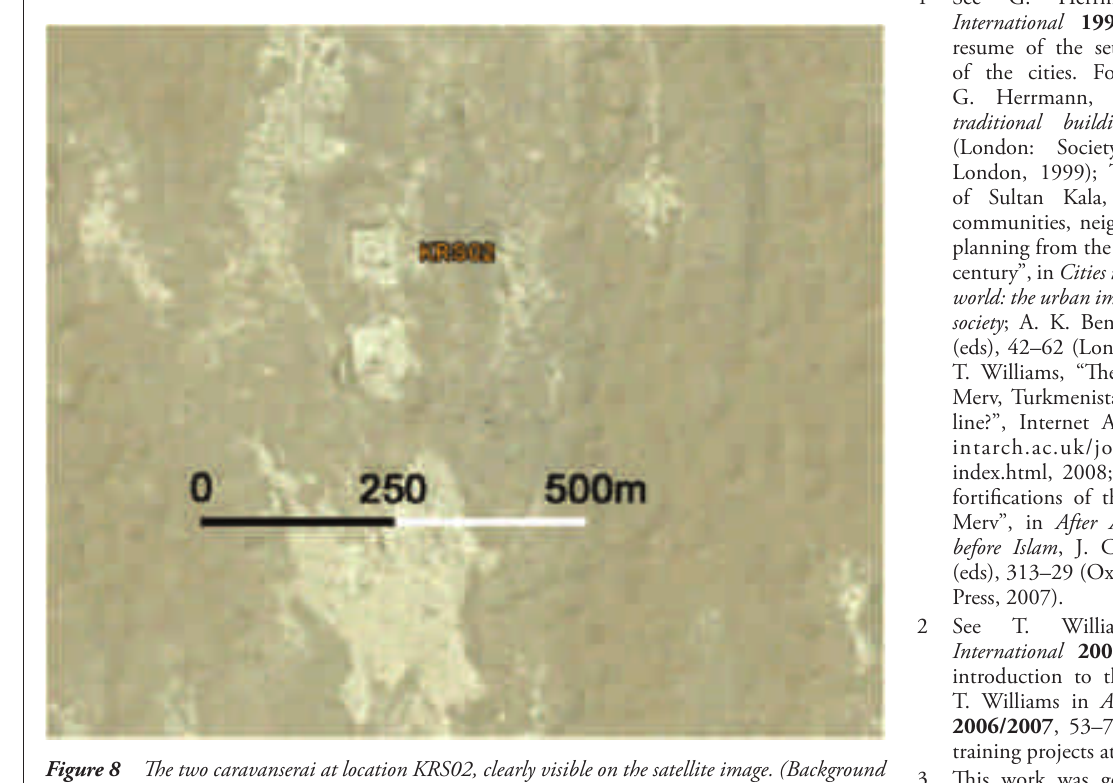
Figure 7 Example of a shepherding outpost in a natural topographic basin in the southern survey area